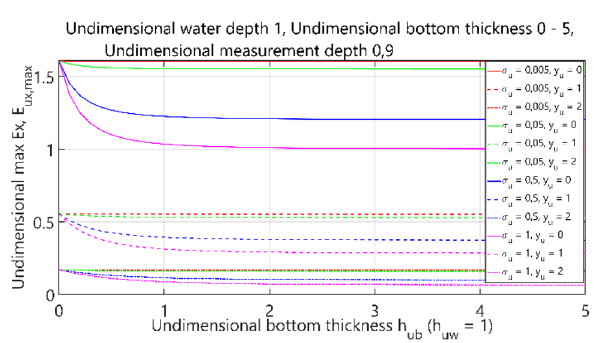
Figure 36. Dependence of E ux,max on h ub .